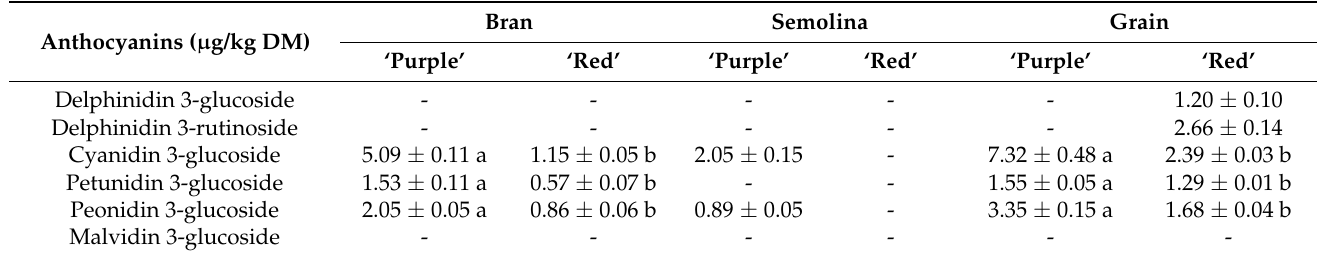
Table 5. Anthocyanin composition in the ‘Purple’ and ‘Red’ landraces (mean ± SD; n = 5) determined by HPLC. Values are reported as mean ± SD ( n = 5). Significant differences between the two varieties for bran, semolina, or grain are indicated by lowercase letters ( t -test, p < 0.05). Anthocyanins ( µ g/kg DM)